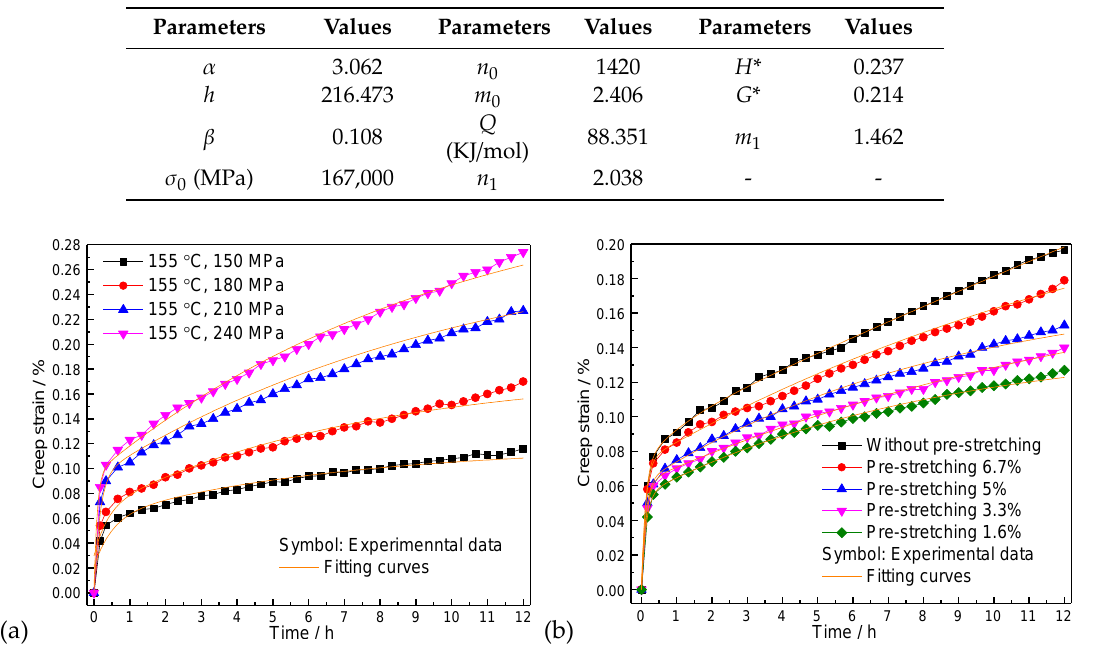
Figure 9. Comparison of experimental and predicted creep curves for 7055 alloy treated by ( a ) T6 under the same temperature, different stresses and without pre-stretching, and by ( b ) T6 under the same temperature, same stress and different pre-stretching values.